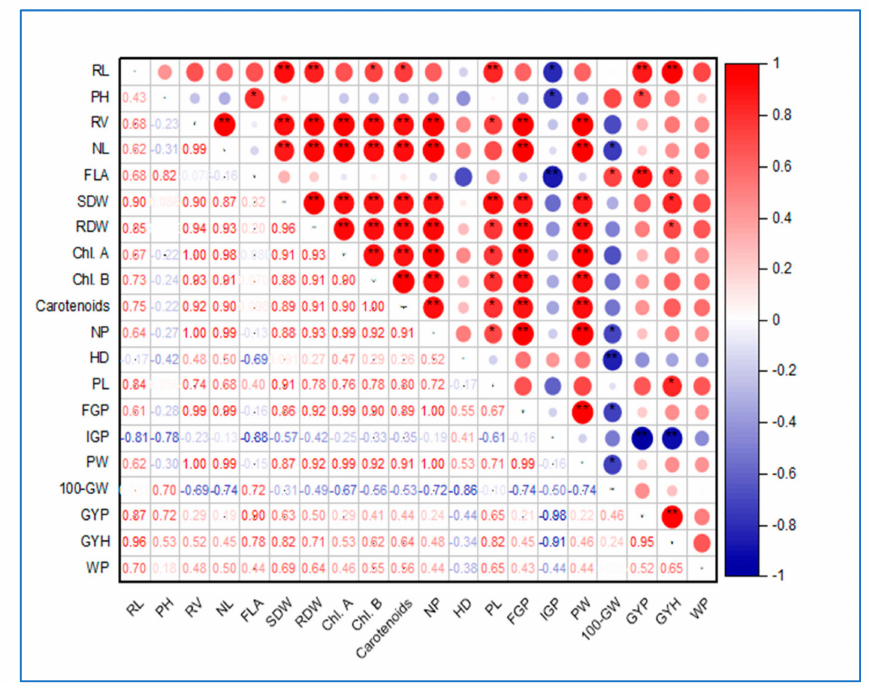
Figure 3. Heat map correlation plot describing Pearson’s correlation between the studied traits of rice cultivars under normal irrigation conditions. RL: root length (cm); PH: plant height (cm); RV: root volume (mm 3 ); NL: number of leaves; FLA: flag leaf area (cm 2 ); SDW: shoot dry weight (g); RDW: root dry weight (g); Chl. A: chlorophyll A (mg g − 1 FW); Chl. B: chlorophyll B (mg g − 1 FW); NP: number of panicle; HD: heading date (day); PL: panicle length (cm); FGP: fertile grain panicle − 1 ; IGP: infertile grain panicle − 1 ; PW: panicle weight (g); 100-GW: 100-grain weight (g); GYP: grain yield plant − 1 (g); GYH: grain yield per hectare (t); and WP: water productivity (kg m 3 ). The large and medium red (positive) and blue (negative) circles indicates a significant (* p ≤ 0.05) or highly significant correlation (** p ≤ 0.01), while the small red (positive) and blue (negative) circles indicates non-significant